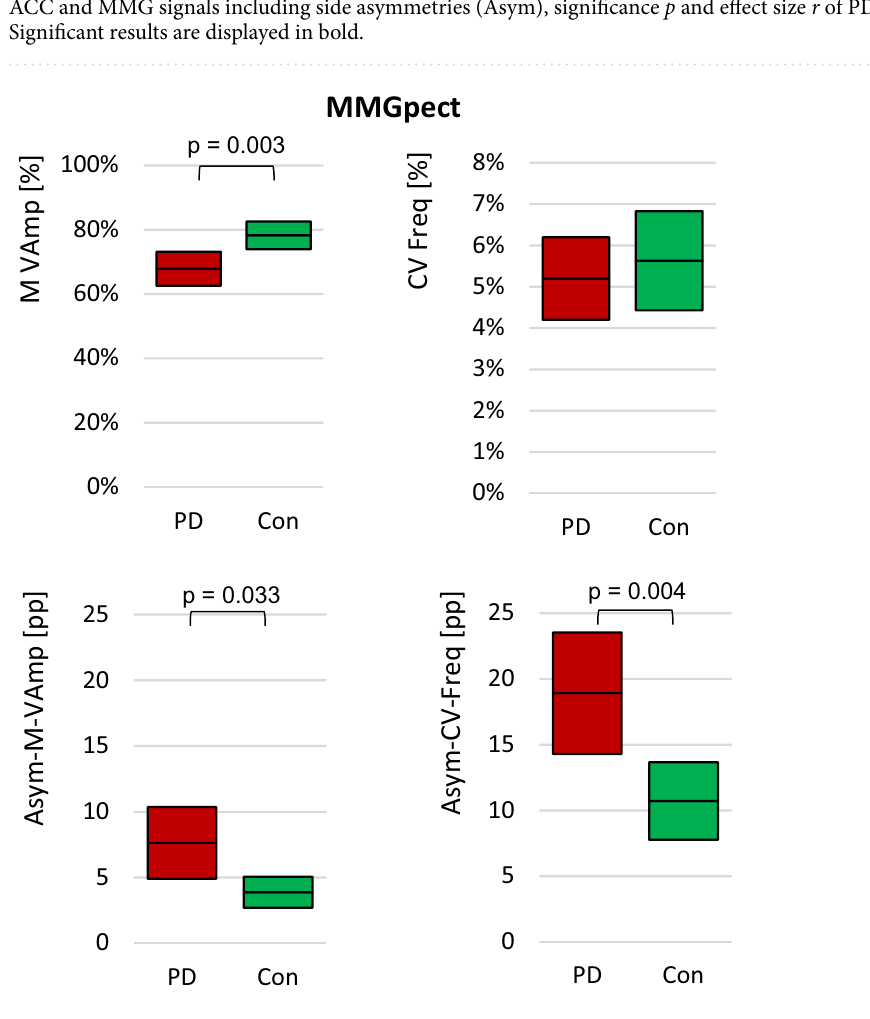
Figure 7. Oscillatory parameters of MMGpect. Displayed are the 95%-CIs of the parameters VAmp and frequency of the MMGpect (above) and of the related interlimb asymmetries (below). The M of VAmp differs significantly with p = 0.003, r = 0.34 and the CV of frequency shows no significant difference between the total group of PD and Con. The side differences, however, are significantly different with p = 0.033 ( r = 0.37) for Asym- M-VAmp and p = 0.004 ( r = 0.48) for